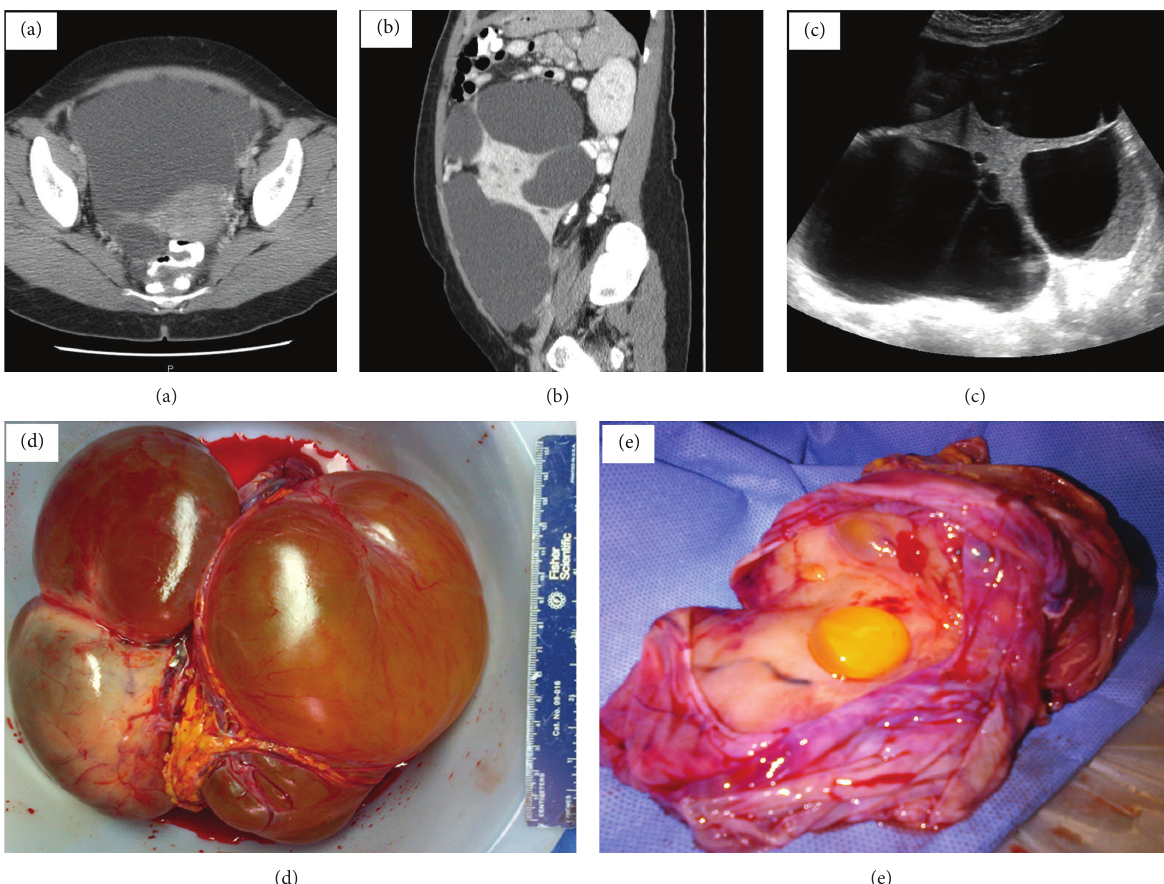
Figure 1: (a) CT image: axial view. (b) CT image: sagittal view. (c) Ultrasound image: transvaginal. (d), (e) Photo: gross